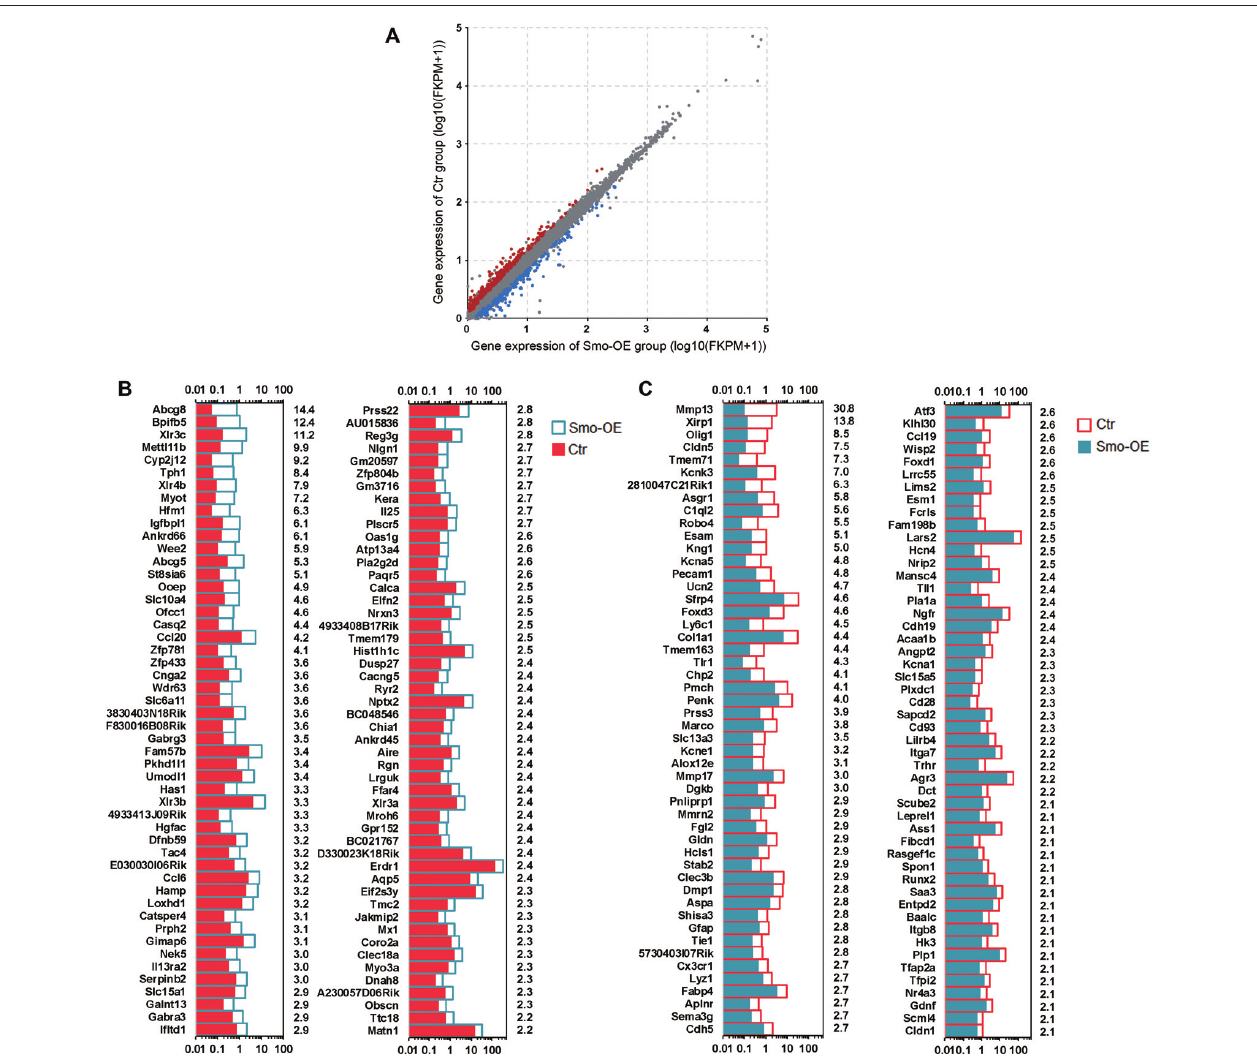
FIGURE 5 | The differentially expressed genes in the Smo-OE and control cochlear epithelium. (A) Scatter plot for expressed genes (Log10(FKPM + 1)) in the Smo-OE and control cochlear epithelium. The dots represent differentially expressed genes between the two groups (fold change > 1.5 and p < 0.05). The blue dots represent the highly differentially expressed genes in the Smo-OE group. The red dots represent the highly differentially expressed genes in the control group. (B) The top 100 highly differentially expressed genes in the Smo-OE cochlear epithelium ranked in descending order. The number on the right side of each panel represents the fold difference in expression for the Smo-OE group vs. the control group. (C) The top 100 highly differentially expressed genes in control cochlear epithelium ranked in descending order. The number on the right side of each panel represents the fold difference in expression for the control group vs. the Smo-OE